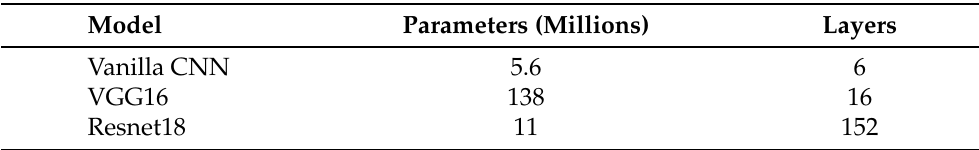
Table 1. A comparison of the three selected deep learning models.